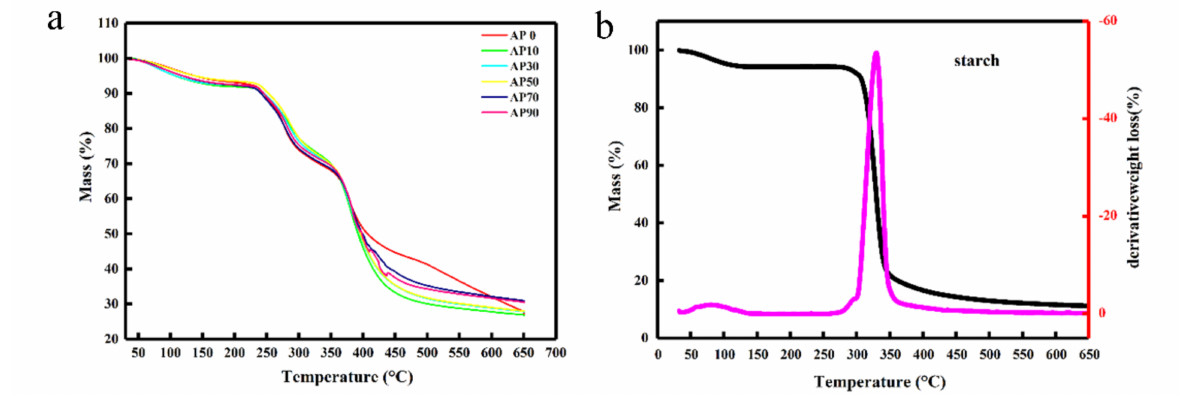
Figure 5. ( a ) TG degradation curves of amylose/amylopectin and starch gel samples and ( b ) TG degradation curves of starch.